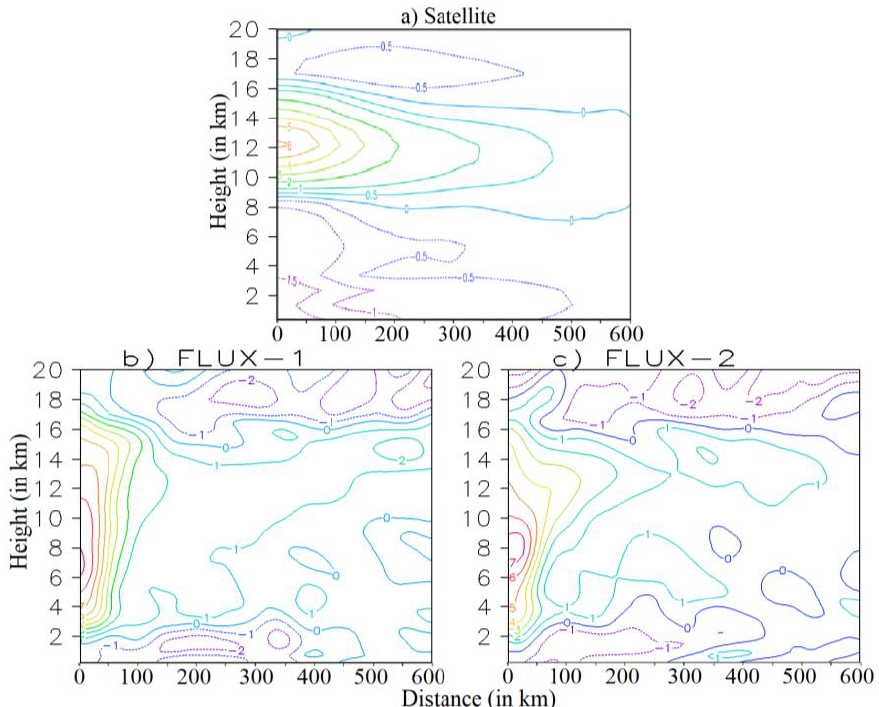
Figure 11. Temperature anomaly at 03 UTC on 2 May 2019 obtained from ( a ) the satellite observation, ( b ) the FLUX-1 experiment, and ( c ) the FLUX-2 experiment (considered from the center of the tropical cyclone to 600 km varying from west to east).